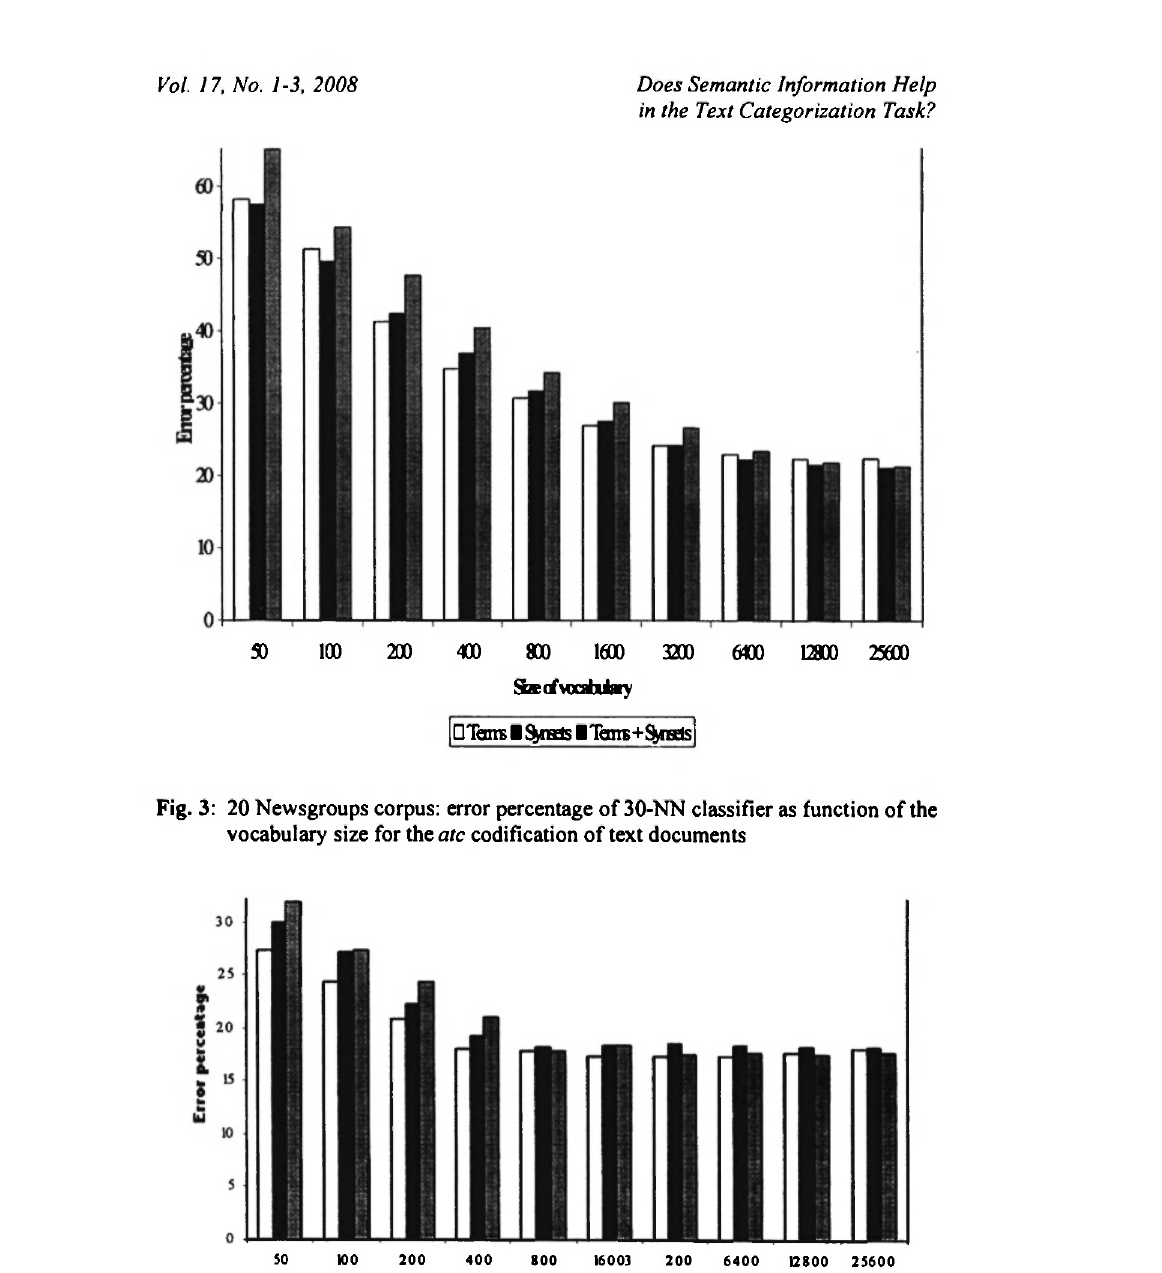
Fig. 4: Reuters corpus: error percentage of 30-NN classifier as function of the vocabulary size for the mtn codification of text